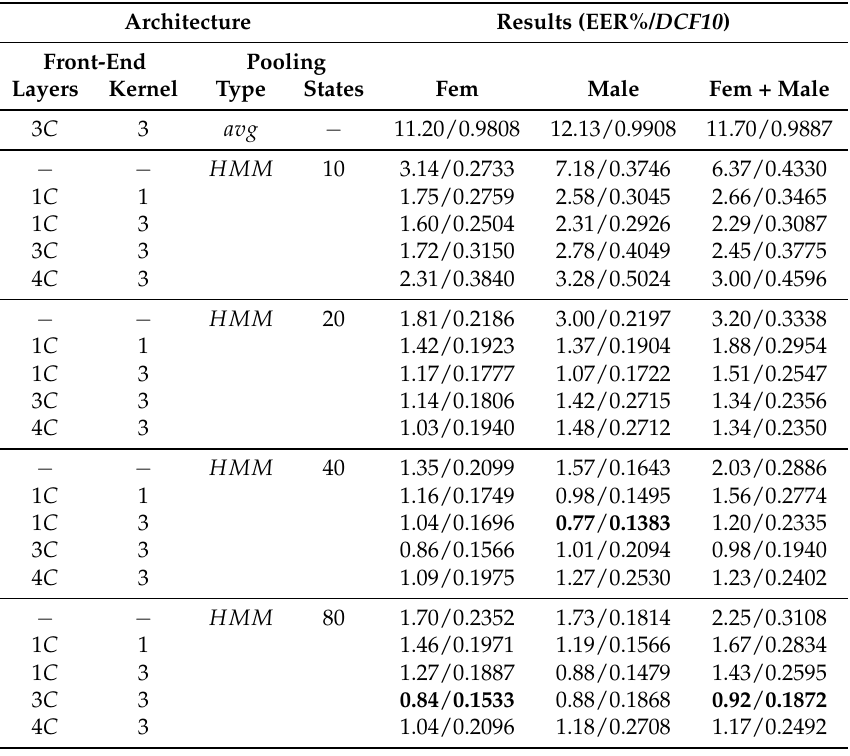
Table 1. Experimental results on RSR2015-Part I [22] eval set, where Equal Error Rate (EER%) and National Institute of Standards and Technology (NIST) 2010 min cost ( DCF10 ) are shown. These results were obtained by training only with a bkg subset and by varying the number of states of the Hidden Markov Model (HMM). The best results are marked in